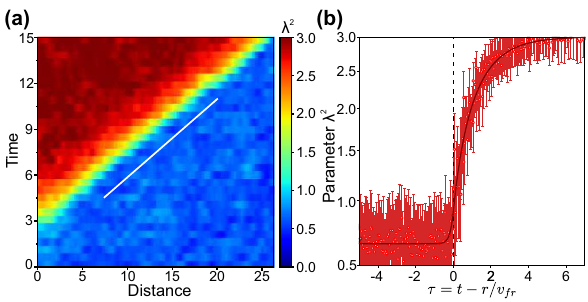
Figure 8. Self-similar front during the growth of nucleus in 3D system: evolution of (cid:31) 2 -field in radial directions shown with white arrows in Fig. 7(b2) for supercritical nucleus. ( a ) and ( b ) are obtained in the same manner as ( d , e ) in Figs. 2 and